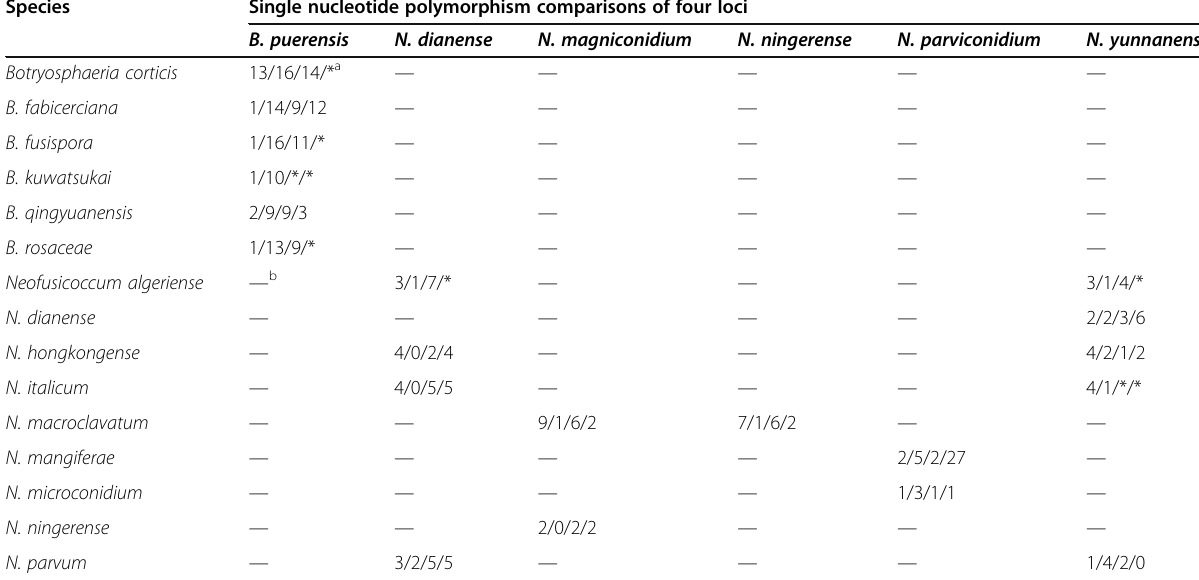
Table 4 Number of fixed SNPs between newly described species and their phylogenetically close taxa Species Single nucleotide polymorphism comparisons of four